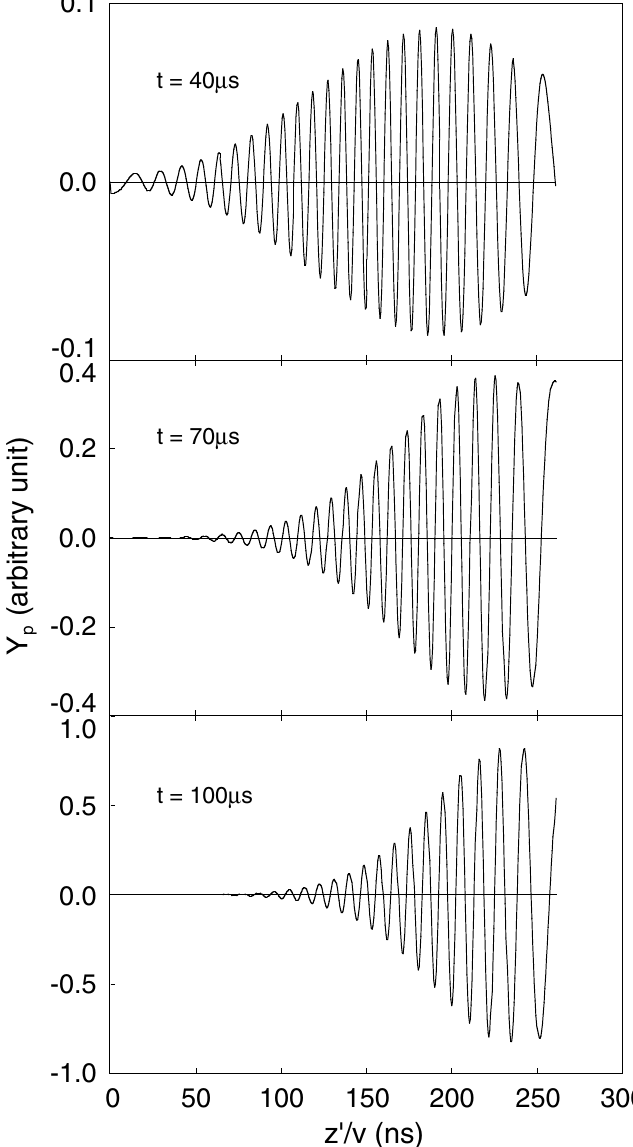
as a function of z 0 =v at time t (cid:1) 40 , 70, and 100 ( s . Here, the p (cid:1) 0 and the parameter values described in the text. The proton bunch is 260 ns long. p